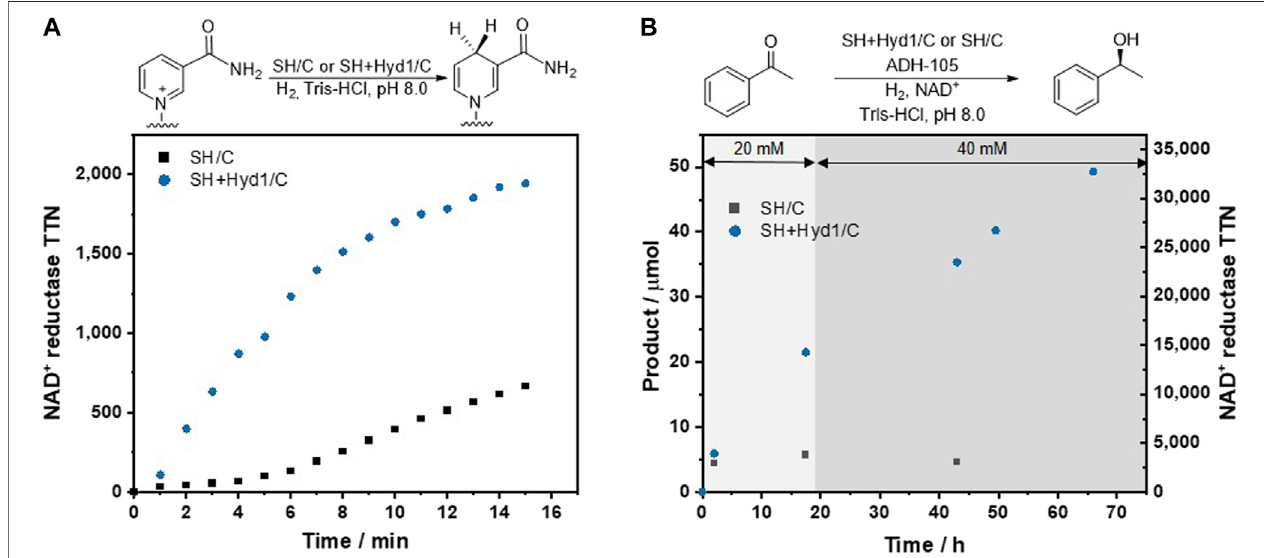
FIGURE 3 | (A) Batch comparison of NAD + reductase activity for H 2 -powered conversion of NAD + to NADH using SH/C (12 μ g SH, 30 μ g BP 2,000) and SH + Hyd1/C [SH (4.8 μ g), Hyd1 (3.4 μ g), BP 2,000 (30 μ g)]. Reactions conditions: H 2 -saturated NAD + (0.1 mM) in Tris-HCl (100 mM, pH 8.0), 800 μ l (see the Supporting Information Supplementary Figure S1 for full NAD + and NADH structures). (B) Batch comparison between SH/C [SH (0.13 mg) and BP 2000 (0.40 mg)], and SH + Hyd1/C [SH (0.13 mg), Hyd1 (0.04 mg) and BP 2000 (0.40 mg)] catalysts using fed-batch conditions for the conversion of acetophenone to ( S )-phenylethanol by H 2 -driven NADH recycling and ADH-105 in solution. Reaction conditions: acetophenone (20 mM plus a further 20 mM after 19 h), NAD + (0.5 mM), Tris-HCl (100 mM, pH 8.0), 2